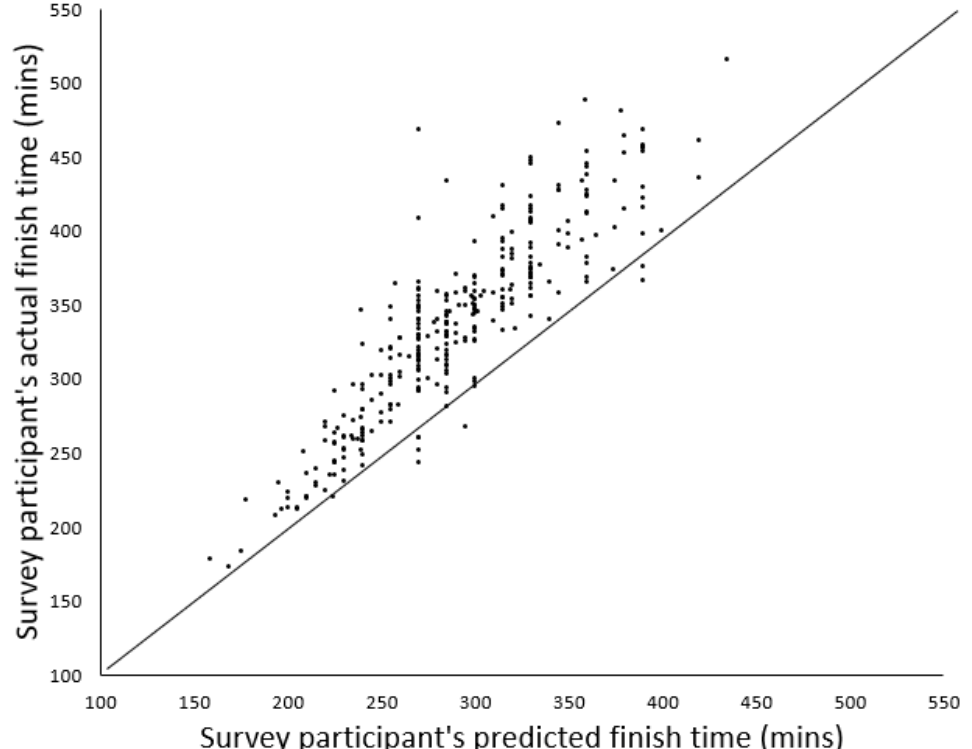
Figure 3. Estimated versus actual finish times in the 2018 VMLM for survey participants. For those who had run marathons previously, the mean finish time for the 2018 VMLM was 40 ± 27 min slower than their previous best marathon time (317 ± 71 min vs. 278 ± 60 min; p < 0.05). Out of 101 runners who had previously run a marathon, one runner ran faster in 2018 VMLM by approximately 1 min.